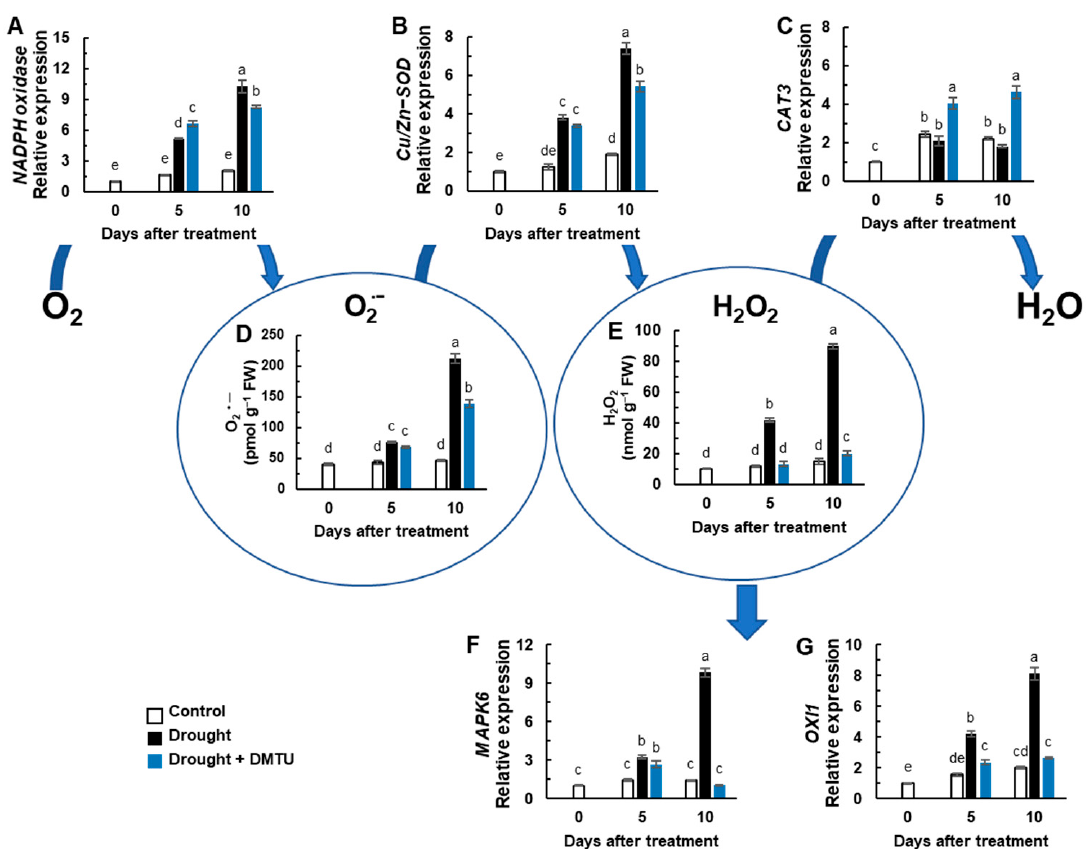
Figure 2. The changes in the concentration of reactive oxygen species (ROS) and the expression of ROS synthesis and signaling-related genes in the leaves of Brassica napus under control, drought, or drought with dimethylthiourea (Drought + DMTU) treatments for 10 days. Expression of ( A ) NADPH oxidase , ( B ) superoxide dismutase (SOD)-related gene, Cu/Zn-SOD , ( C ) catalase 3 (CAT3), ( F ) transcription factor, MAPK6 , and ( G ) oxidative signal-inducible ( OXI1 ), and the concentration of ( D ) O 2 •− and ( E ) H 2 O 2 . The transcriptional levels in control plants at day 0 were set to 1. Results are represented as mean ± SE for n = 3. Means with different letters are significantly different at p < 0.05, according to Duncan’s multiple range test.